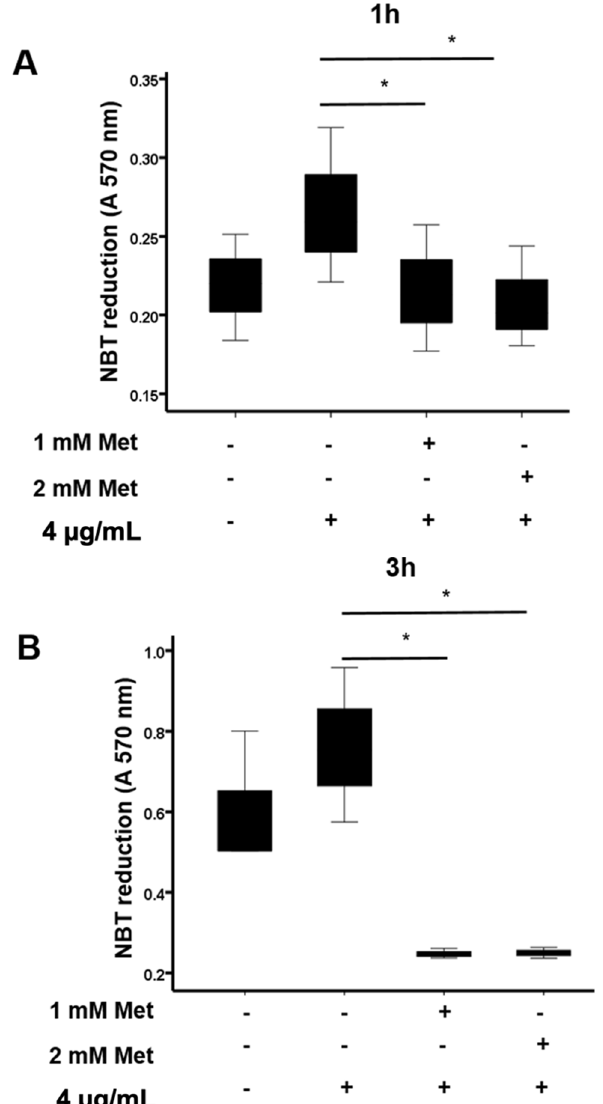
Figure 2. Effect of metformin on ROS production in M2 polarized macrophages. M2 macrophages were incubated in the absence or presence of metformin (1 and 2 mM), then stimulated by LPS (4 µg/mL) for 1 ( A ) and 3 h ( B ). The relative intracellular ROS production was determined by recording the reduction in NBT at 570 nm. Data are mean of O.D. ± SD (n = 3). * p value < 0.05.